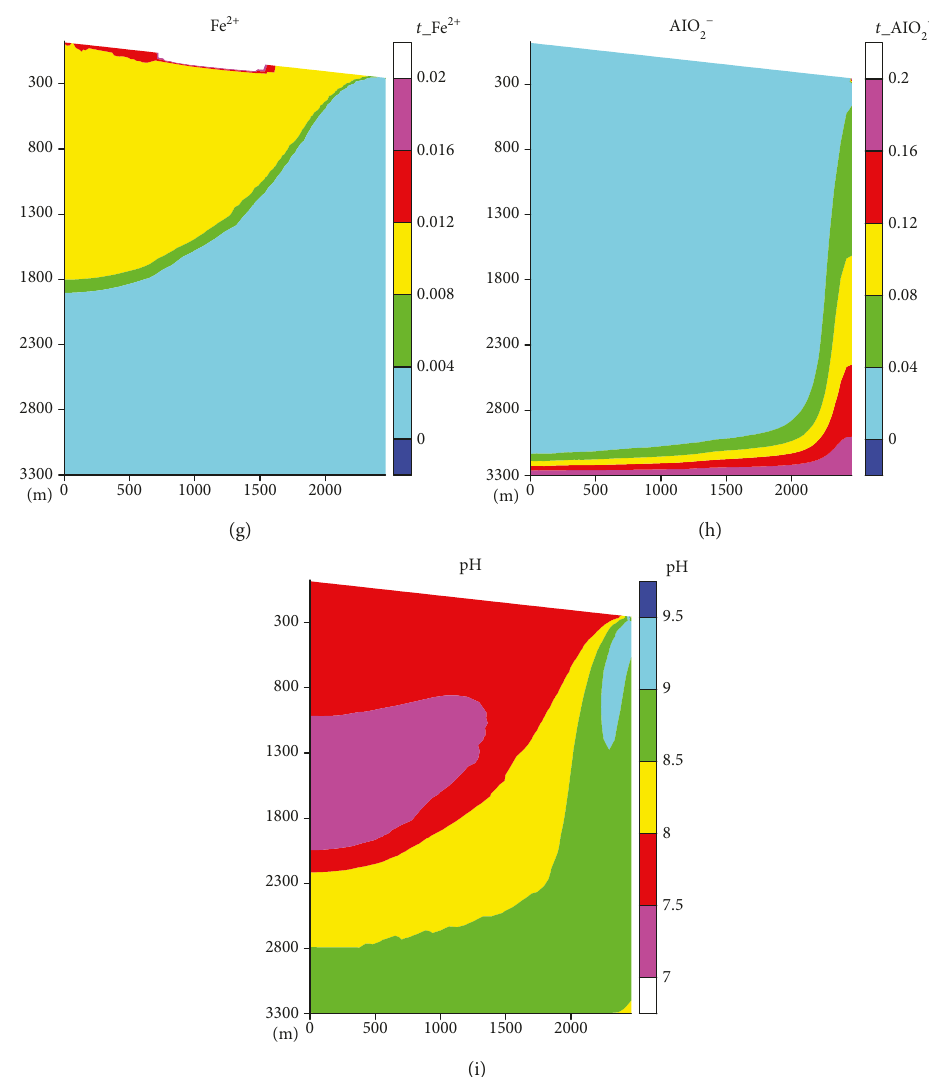
Figure 6: Chemical components in fl uid (mg/L) and pH value after a simulated time period of 8000